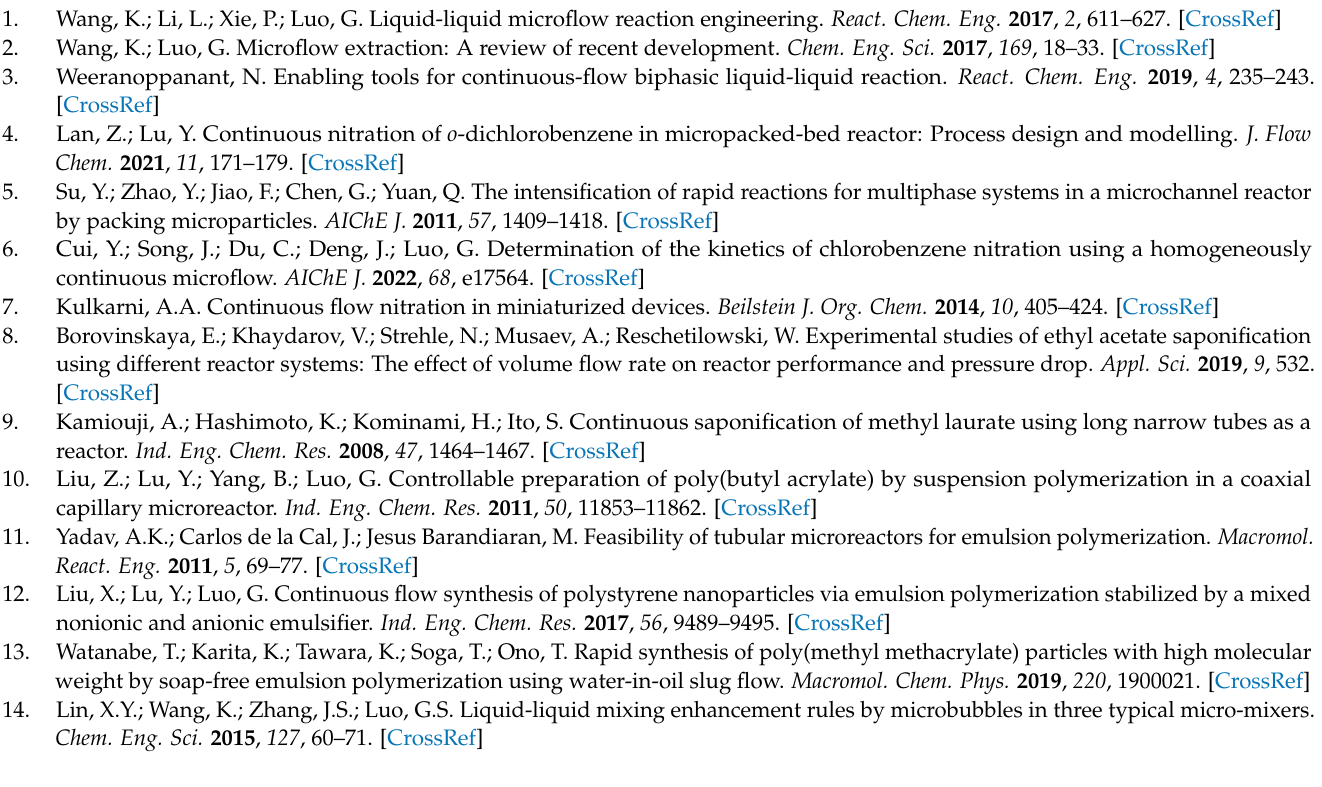
Figure S4: Experimental data (filled circles) and the correlation data (dashed line) under